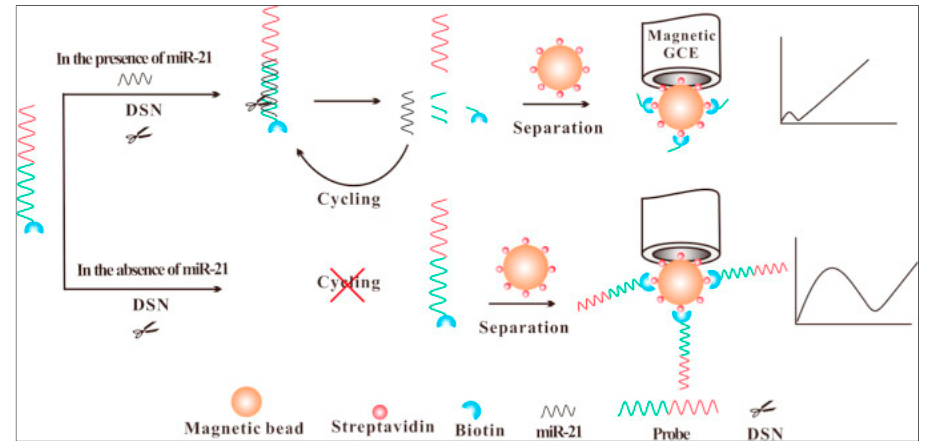
Figure 15. Experimental principle of the biosensor (reproduced with permission from the publisher)